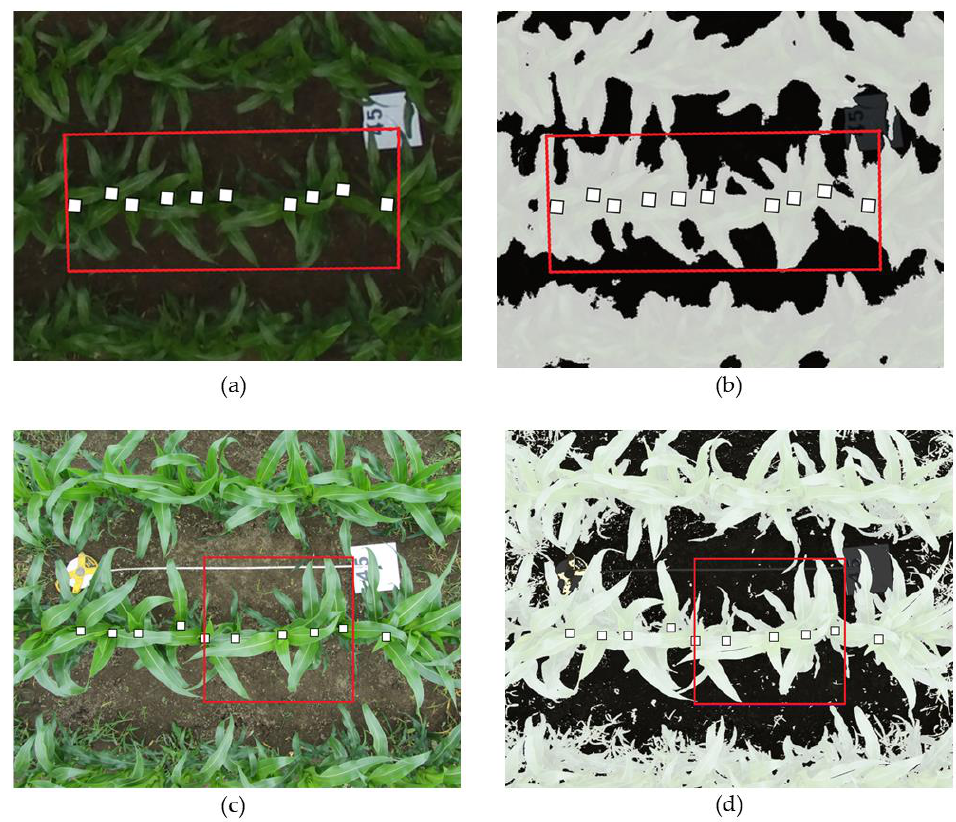
Figure 4. Screenshots extracted from the user interface showing a quadrat (red rectangle) and the sampled plants (identified with white square markers) in a nadir image: ( a ) clipped orthomosaic from the UAV mode; ( b ) its segmented images superimposed onto the original photo; ( c ) RGB single image from the zip line mode; and ( d ) its segmented image superimposed on the original photo. Quadrat length L = 1.7 m for ( a , b ); L = 1 m for ( c , d ). The pixel count included both leaves and plant stems, especially when viewed at an oblique angle ( α > 0 ◦ ). In addition, the calculated area was called apparent because only the vegetation pixels visible in the image were considered. The size of the objects represented by those pixels was considered constant and equal to the GSD, regardless of their actual distance from the camera, with the 3D position of each pixel being